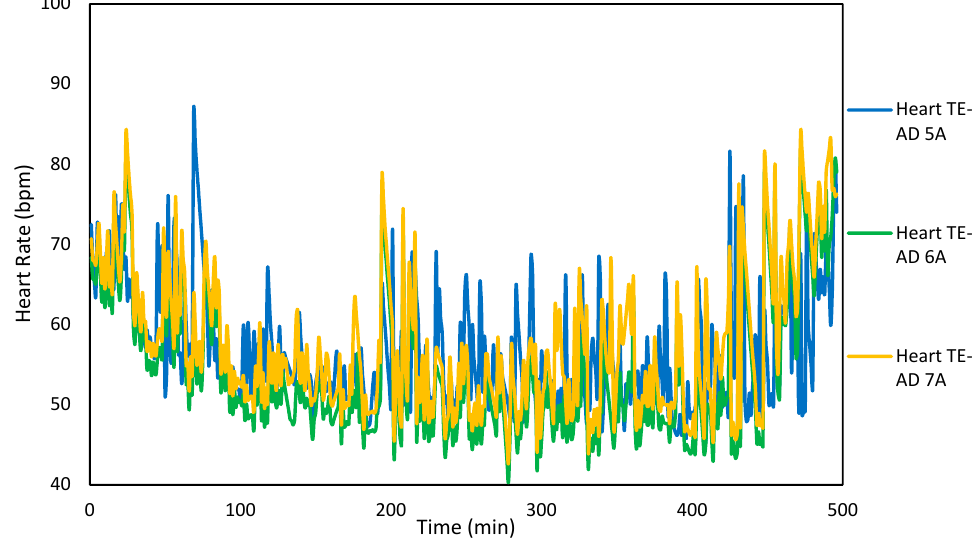
Figure 10. Variation in heart rate of the occupants at different operating powers.